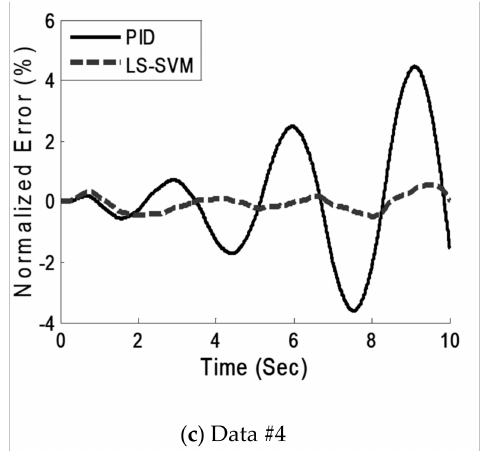
Figure 8. Comparison of the normalized errors of Model 1 in di ff erent tests.